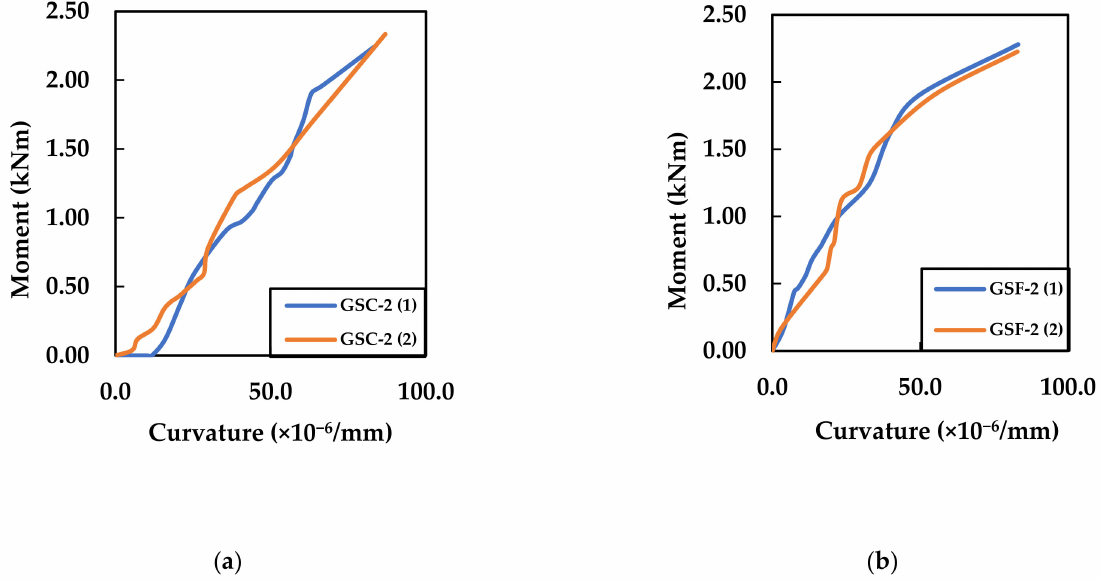
Figure 16. Moment–curvature behaviour of ( a ) GSC 2 and ( b ) GSF